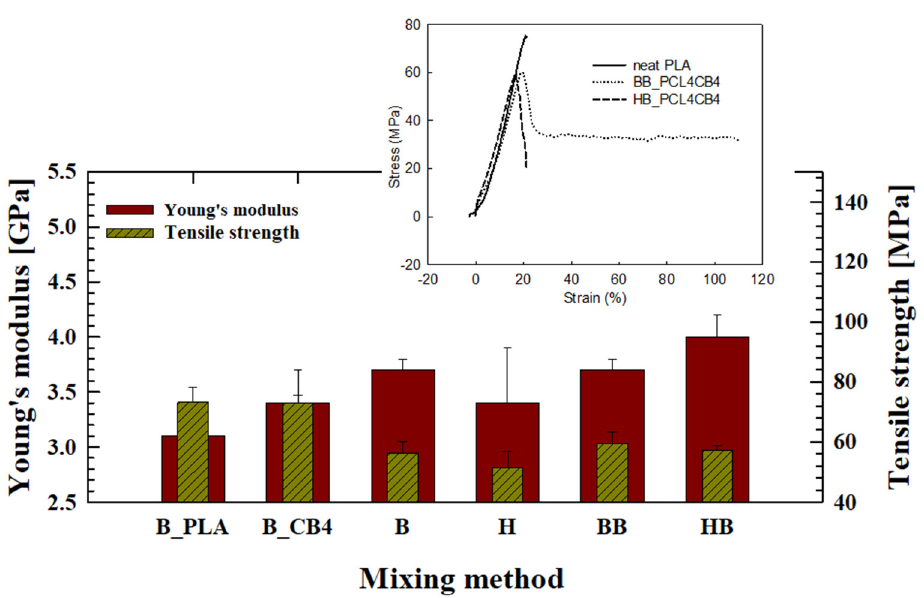
Figure 9. Comparison of mechanical tensile properties of ternary composites depending on mixing method. Table 5. Comparison of DC electrical conductivity of various composites containing the CB particle used in this